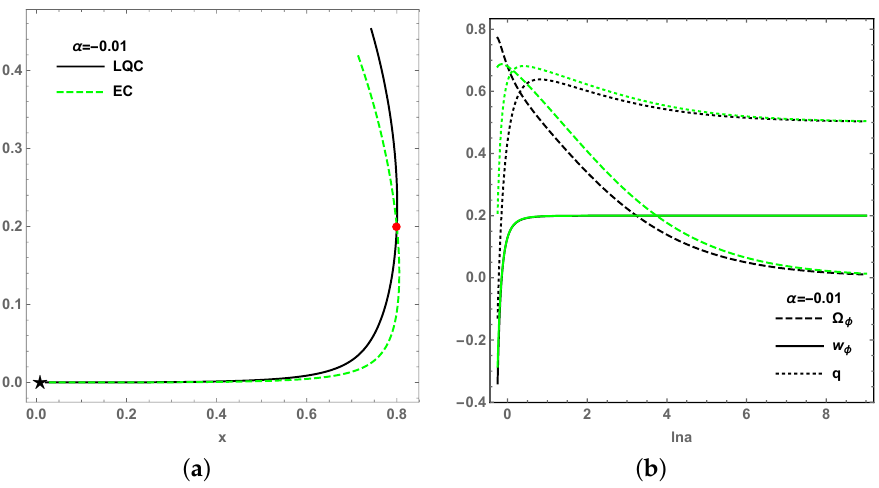
Figure 13. ( a ) The x - y phase plane projected from 4-dim system of { x , y , z , σ } for both LQC(black) and EC(green dash) around P e 2 , corresponding to the parameters of γ k = 6 The initial points are ( 0.8,0.2, 0.1,4 ) for LQC, and ( 0.8,0.2, 0,4 ) for EC. The star stands for the final state of the evolution, while the solid circle stands for the initial point. ( b ) the evolution of the cosmological quantities of Ω φ , w φ and q for both LQC(black) and EC(green) cases around P e 2